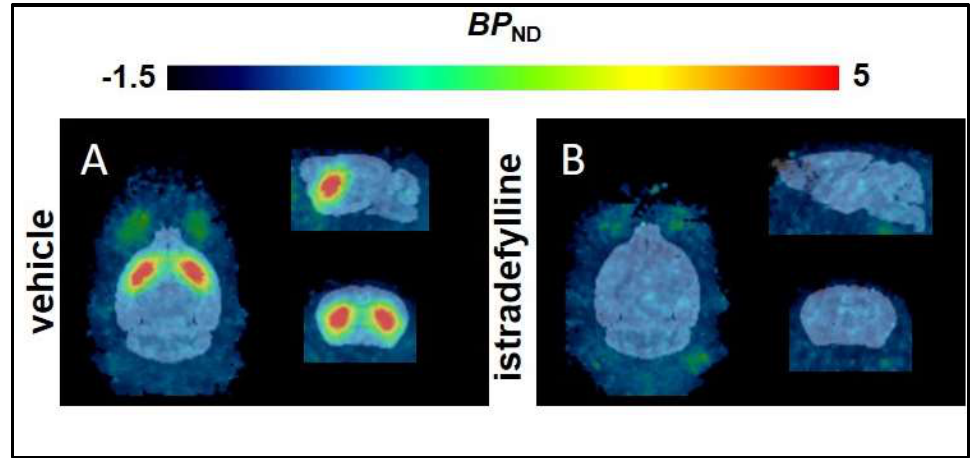
Figure 1. Mean BP ND maps derived from simplified reference tissue modelling (SRTM) of [ 18 F]FLUDA in the brain of healthy CD–1 mice pre–treated with ( A ) vehicle ( n = 8) or ( B ) the A 2A R antagonist istradefylline (1 mg/kg bodyweight, IV, n = 4). Table 3. Striatal [ 18 F]FLUDA BP ND (SRTM, using the Ma–Benveniste–Mirrione–T2 Atlas whole striatum template, or 1 mm diameter spherical VOI placed in the centroid of the target and reference region of vehicle (veh, n = 8) and istradefylline pre–treated (istra, n = 4) healthy CD–1 mice.